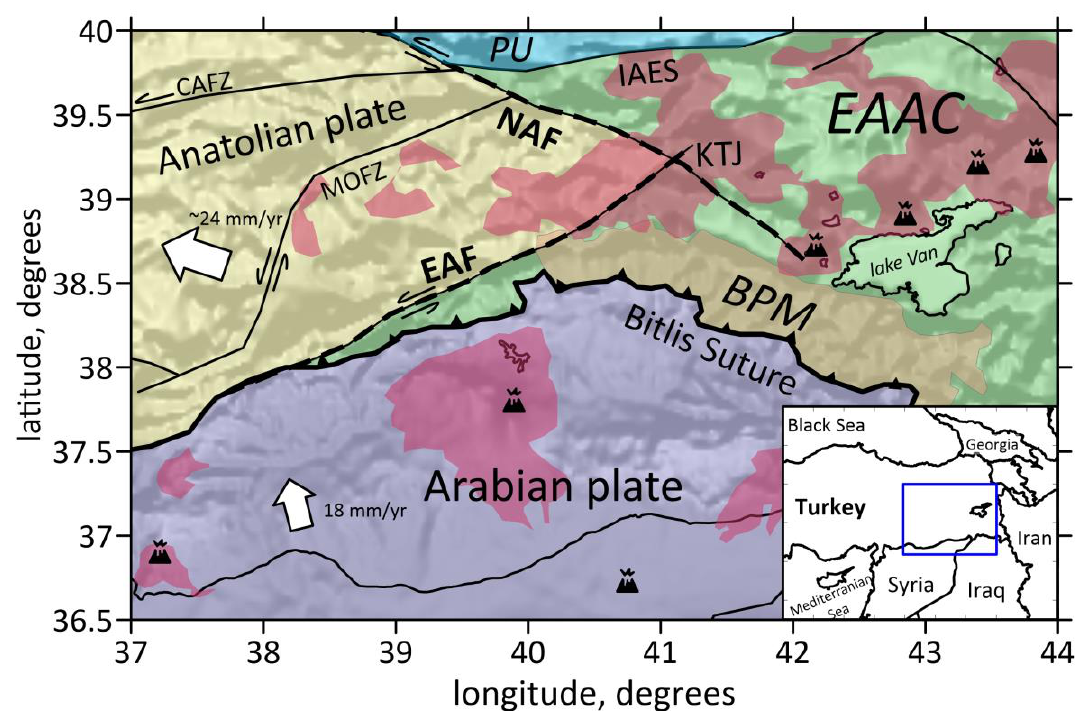
Figure 1. The simplified regional tectonic map of Eastern Turkey with topographic relief (modified from [6]). Pink areas are Neogene – Quaternary volcanism. Arrows indicate the direction of plate and fault motions. BPM – Bitlis-Poturge Massif; CAFZ – Central Anatolia Fault Zone; EAAC — East Anatolian Accretionary Complex; EAF — East Anatolian Fault; IAES – Izmir-Ankara-Erzincan Suture; KTJ — Karlova Triple Junction; MOFZ — Malatya-Ovacik Fault Zone; NAF — North Anatolian Fault; PU — Pontide Unit.